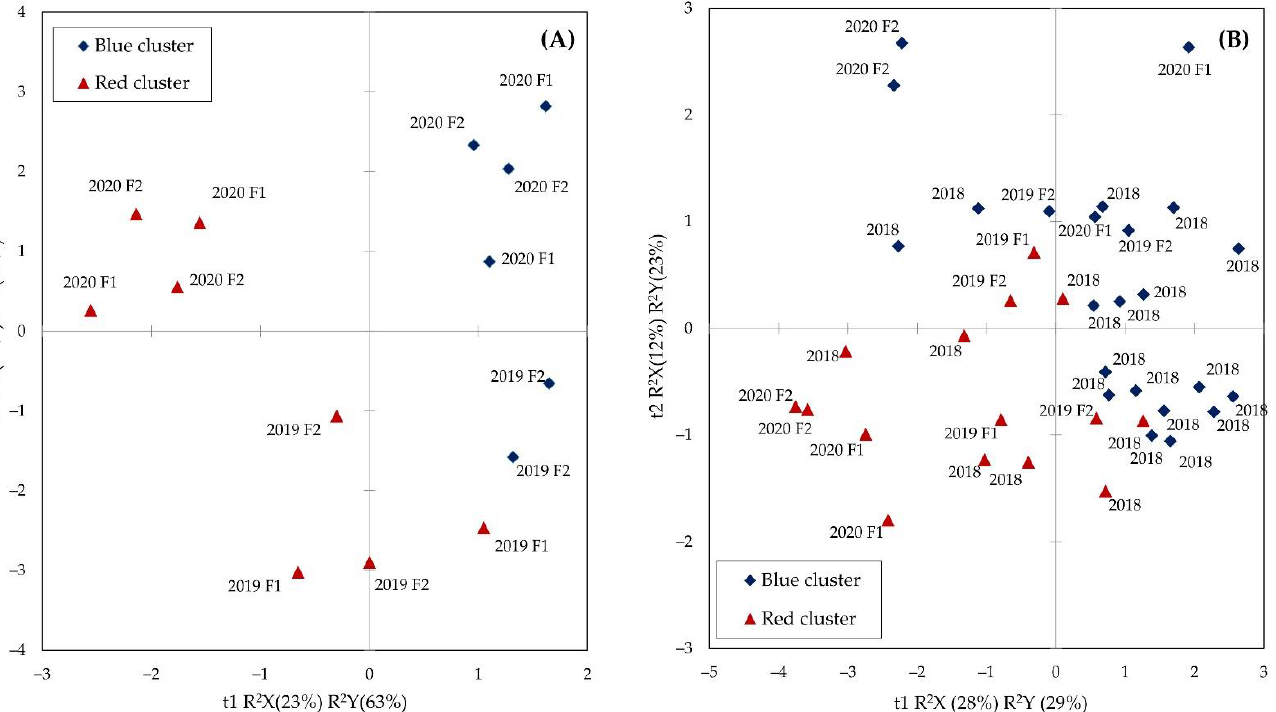
Figure 8. Score plot of the accessions belonging to the two different genetic clusters (red/blue) on the two latent variables (t) calculated by PLS-DA. ( A ) Accessions #2 (blue) and #3 (red) cultivated in the in situ experiments; ( B ) 24 accessions collected in 2018 added with the #2 and #3 accessions cultivated in situ.